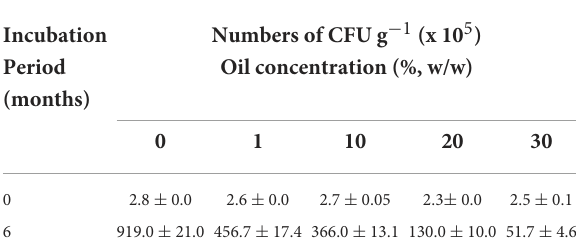
TABLE 2 Number of hydrocarbonoclastic microorganisms in each oil